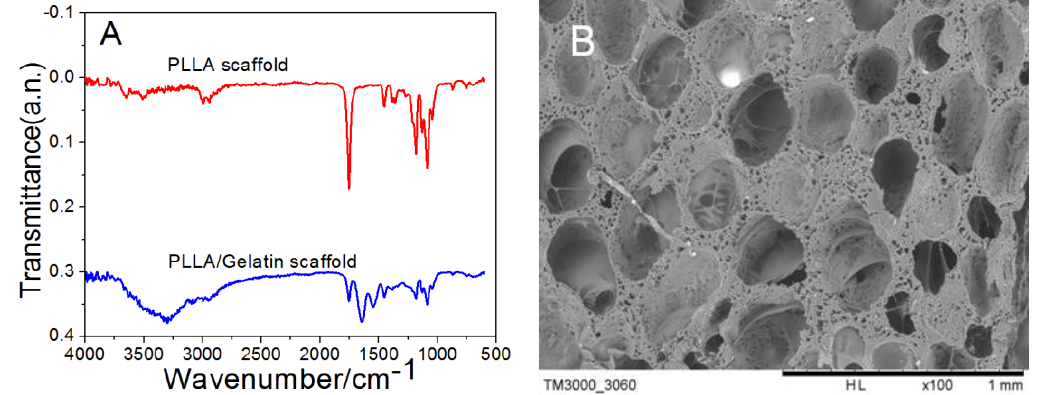
Figure 3. Fourier transform infrared spectroscopy (FTIR) spectra of poly- L -lactic acid (PLLA) and PLLA/gelatin scaffold as well as scanning electron microscopy (SEM) photograph showing pore surface of PLLA scaffold. ( A ) FTIR spectra of PLLA and PLLA/Gelatin scaffolds; ( B ) SEM photograph of PLLA